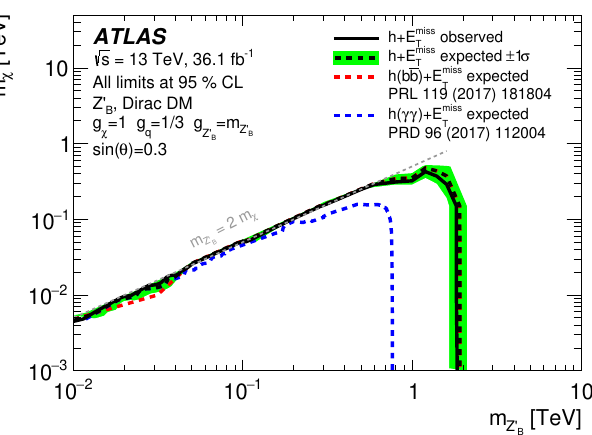
Figure 14. Exclusion contours for the VBC model in the ( m and sin (cid:18) = 0 : 3. The dashed lines indicate the expected exclusion contours from the two separate channels and their combination, while the solid line shows the observed exclusion, presented only for the combined result. The band around the expected combined contour shows the e(cid:11)ect of a one-standard-deviation variation of the total systematic uncertainties. At high mediator masses, the combined exclusion fully overlaps with the exclusion from the h ( b (cid:22) b ) + E miss